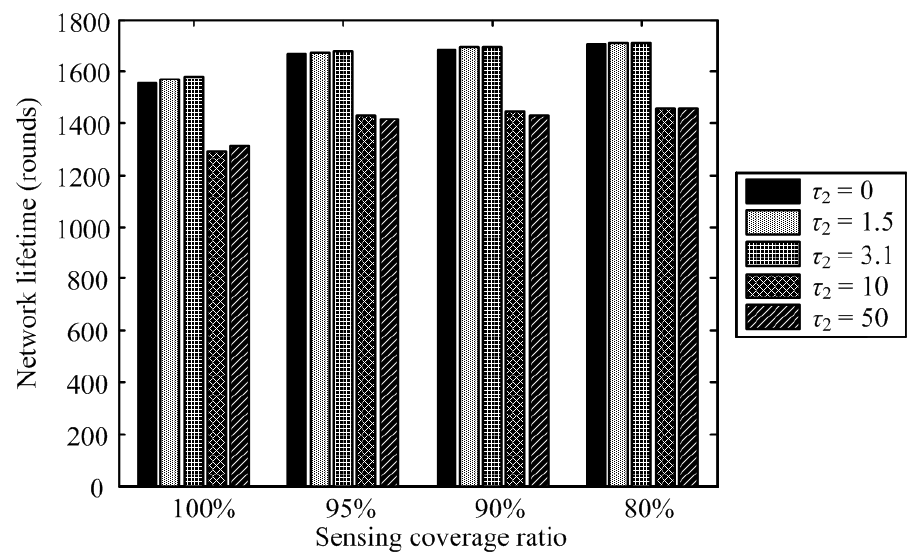
Figure 6. Comparison of network lifetimes under different sensing coverage ratios with varying τ when set τ = 1. 2 1